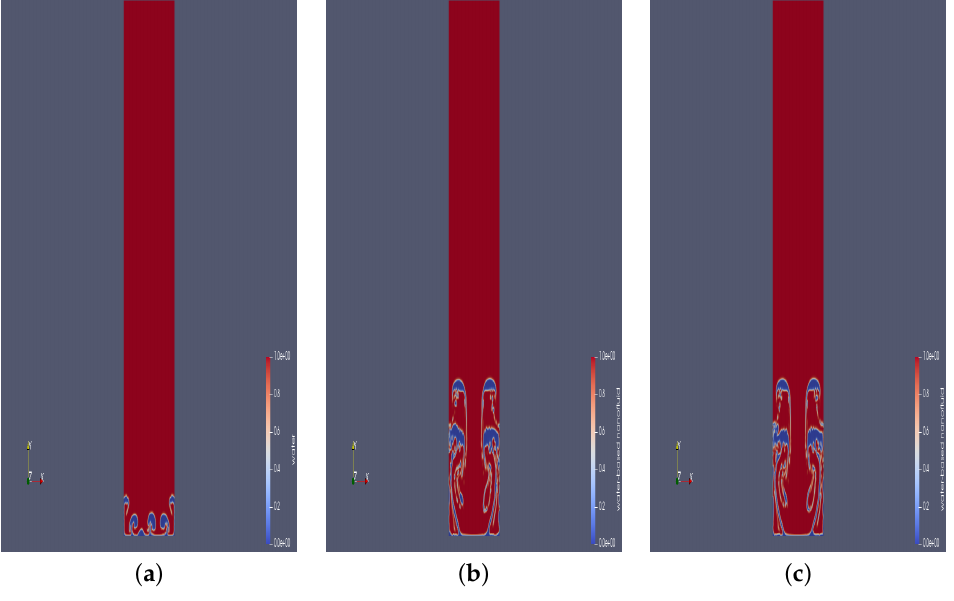
Figure 14. Solutions for multi-phase mixtures at time t = 10 s and ϕ = 0.05. ( a ) Water. ( b ) Water- Al 2 O 3 nanofluid. ( c ) Water-TiO 2